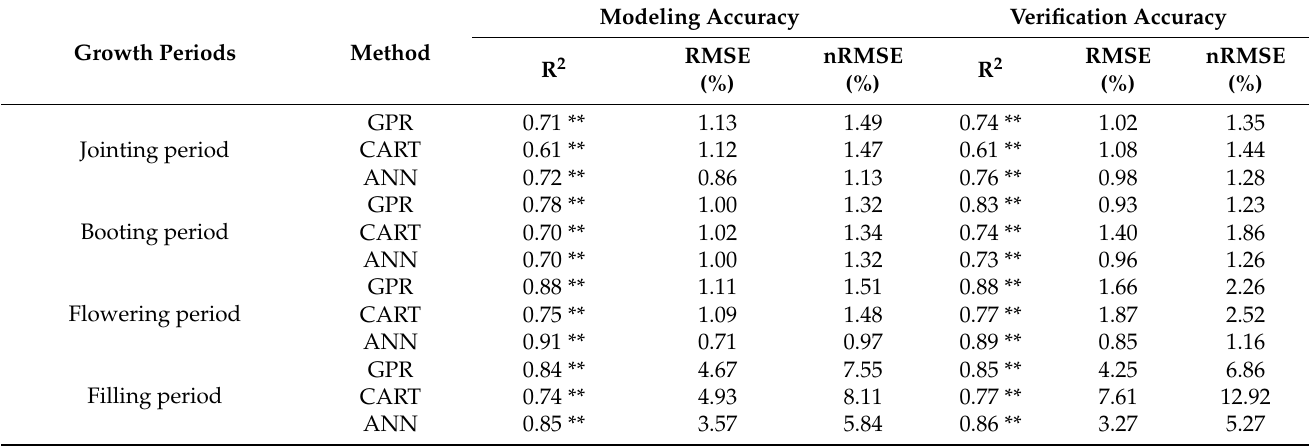
Table 3. The LWC estimation results obtained by adopting wavelet coefficients combined with GPR, CART, and ANN for different growth